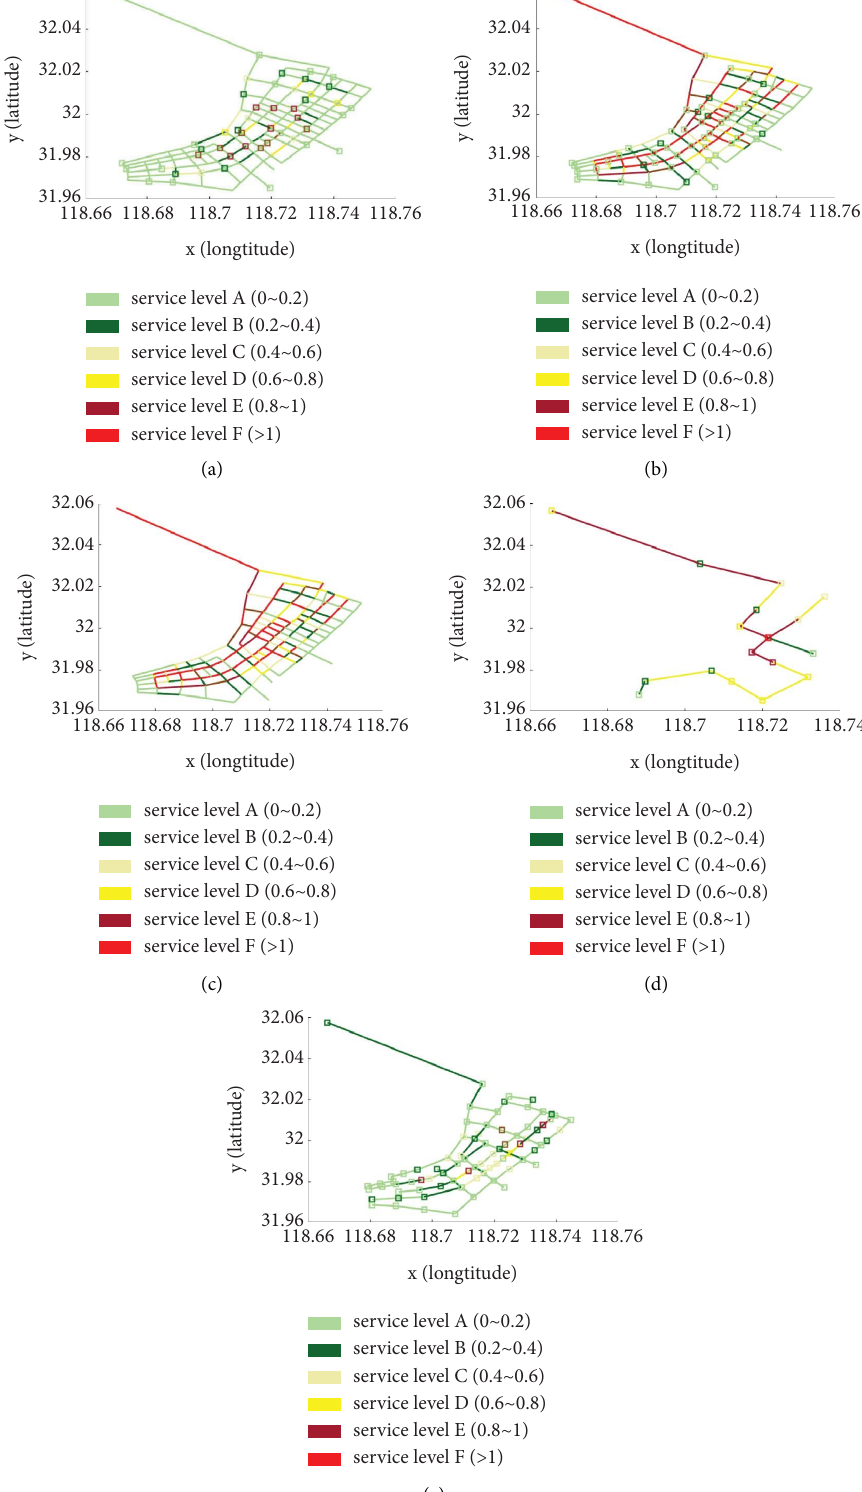
Figure 15: Service level of best solution. (a) Bicycle subnetwork. (b) Car subnetwork. (c) Car hailing subnetwork. (d) Metro subnetwork. (e) Bus